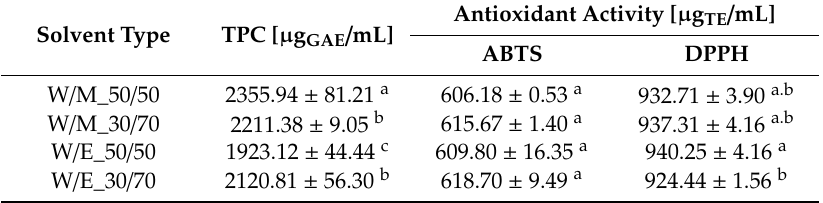
Table 3. Characteristics of natural horsetail extracts in terms of the total phenolic content and antioxidant activity. The results are expressed as mean ±